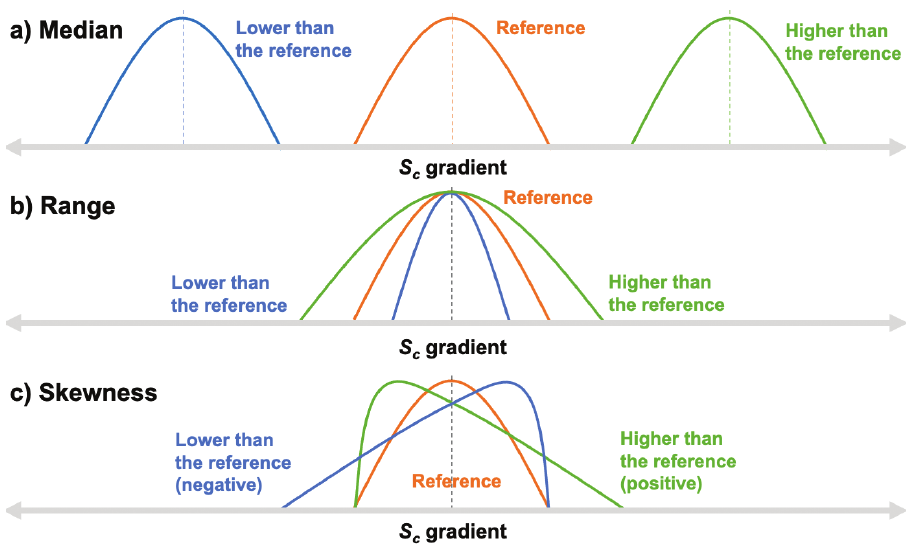
Figure 1. Schematic representation illustrating how the variation in the distribution of community species richness ( S ), associated with individual species is described by the ( a ) median, ( b ) range and ( c ) c